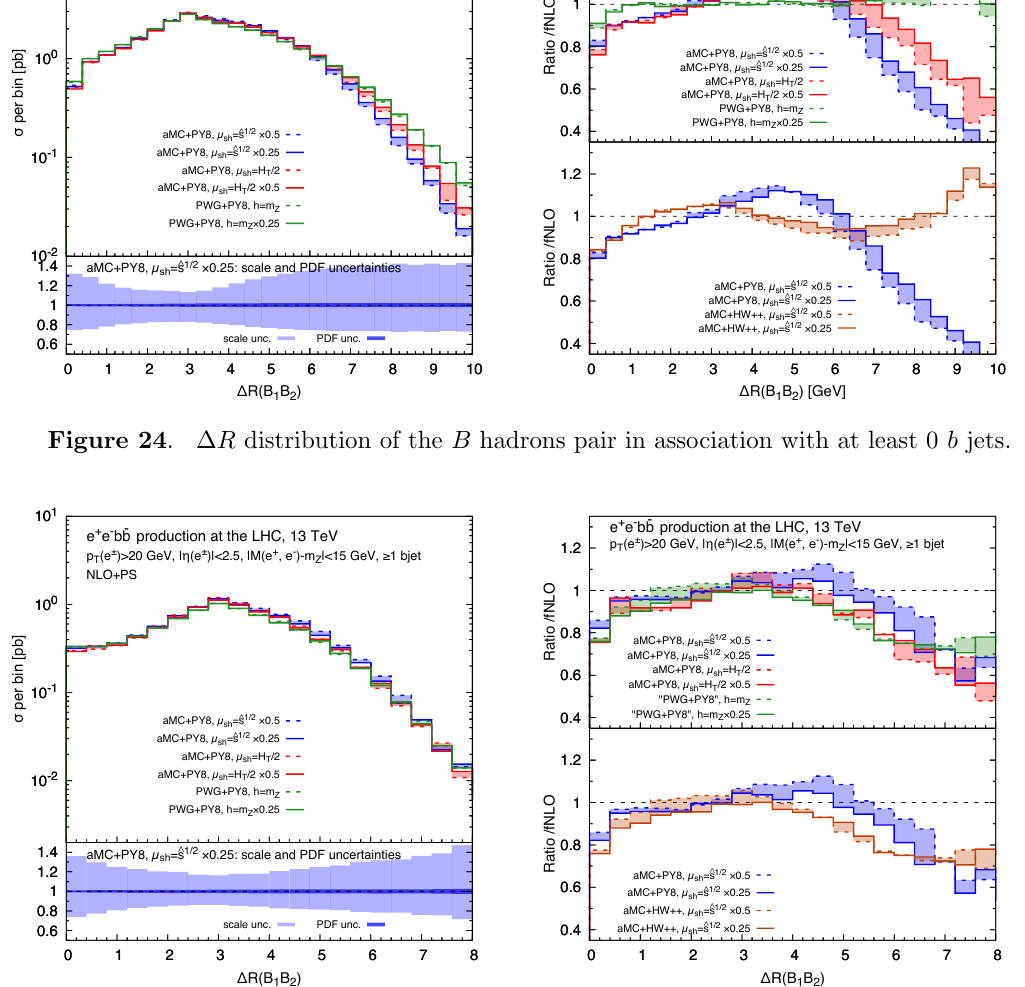
Figure 25 . (cid:1) R distribution of the B hadrons pair in association with at least 1 b